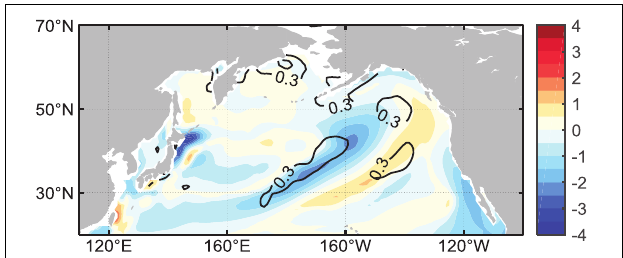
FIGURE 8 | The temperature changes between EAKF and Projection-OI averaged at the 50–150 m vertical depth (shaded; units: ◦ C) in the initial condition and the differences of ACC between the EAKF and Projection-OI hindcasts averaged in all lead months (contour, only 0.3 and 0.4 contours are plotted). The depth of 50–150 m covers the annual variation of mixed-layer depth.